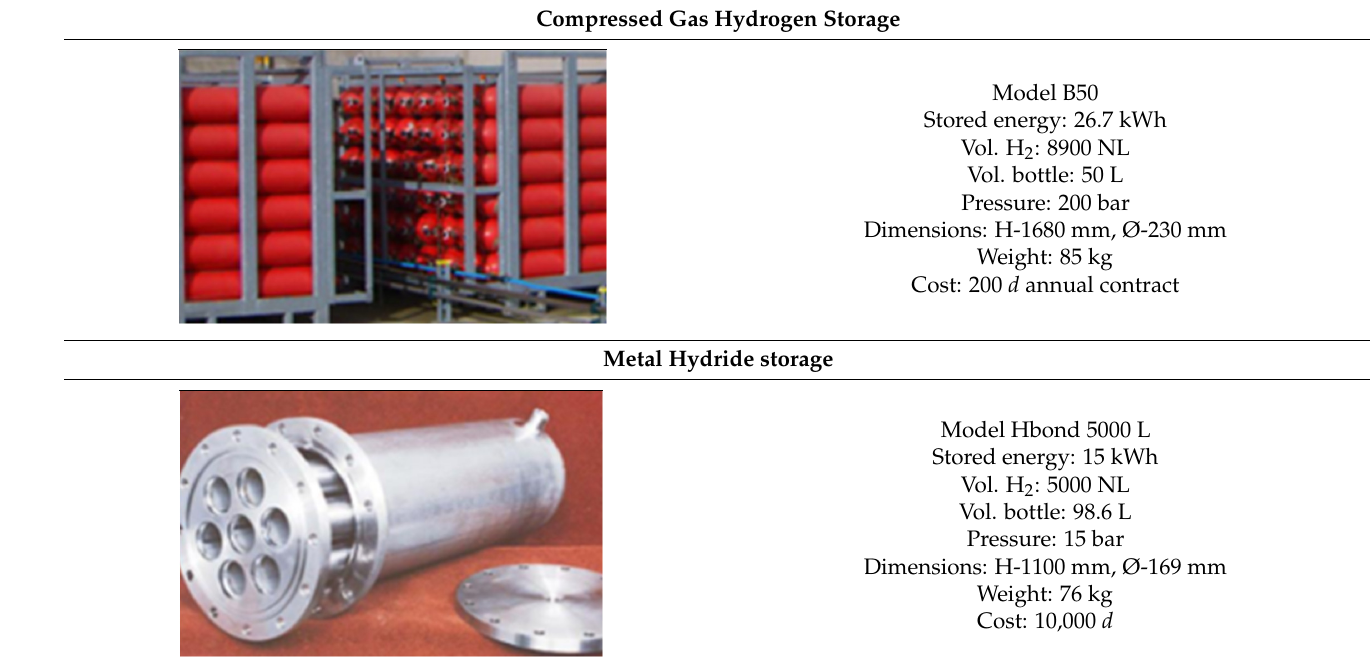
Table A5. Commercial examples of Hydrogen storage. Data provided by the manufacturer.